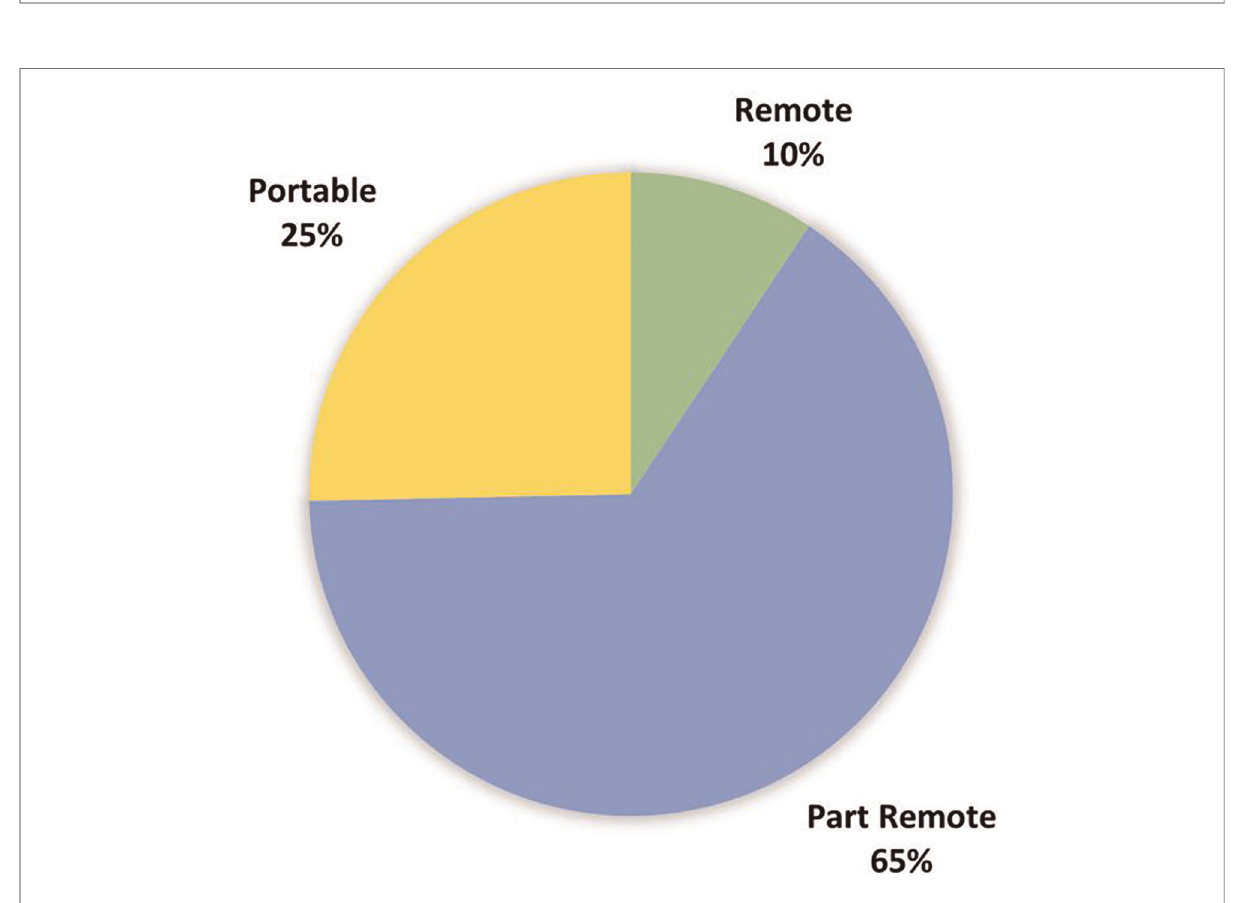
FIGURE 4 Technology results divided by application categories based on the criteria described in Table 2 . Most technologies were categorised as part remote (65%), whilst 19 technologies were categorised as portable (25%), and 7 technologies were identi fi ed as fully remote